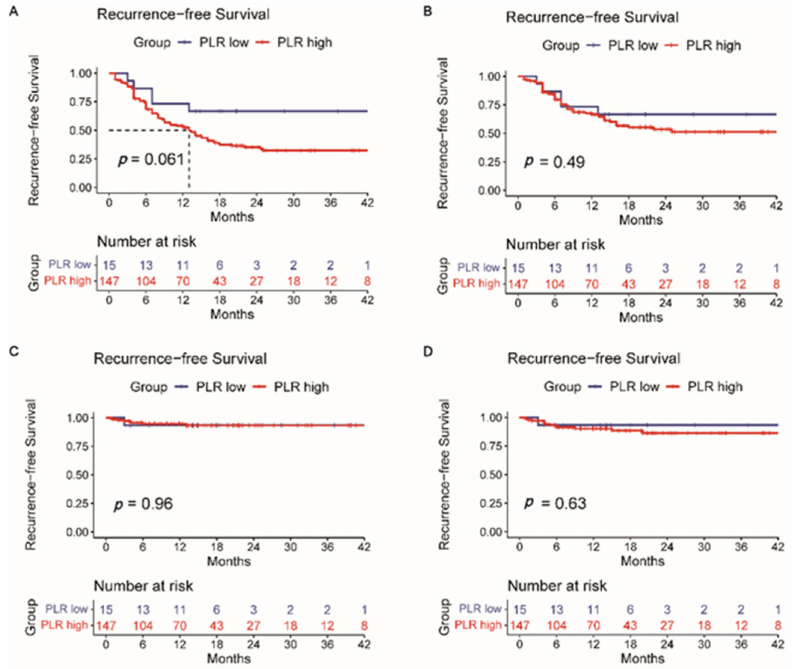
Figure 4. The value of PLR in predicting ( A ) recurrence-free survival, ( B ) intrahepatic recurrence,